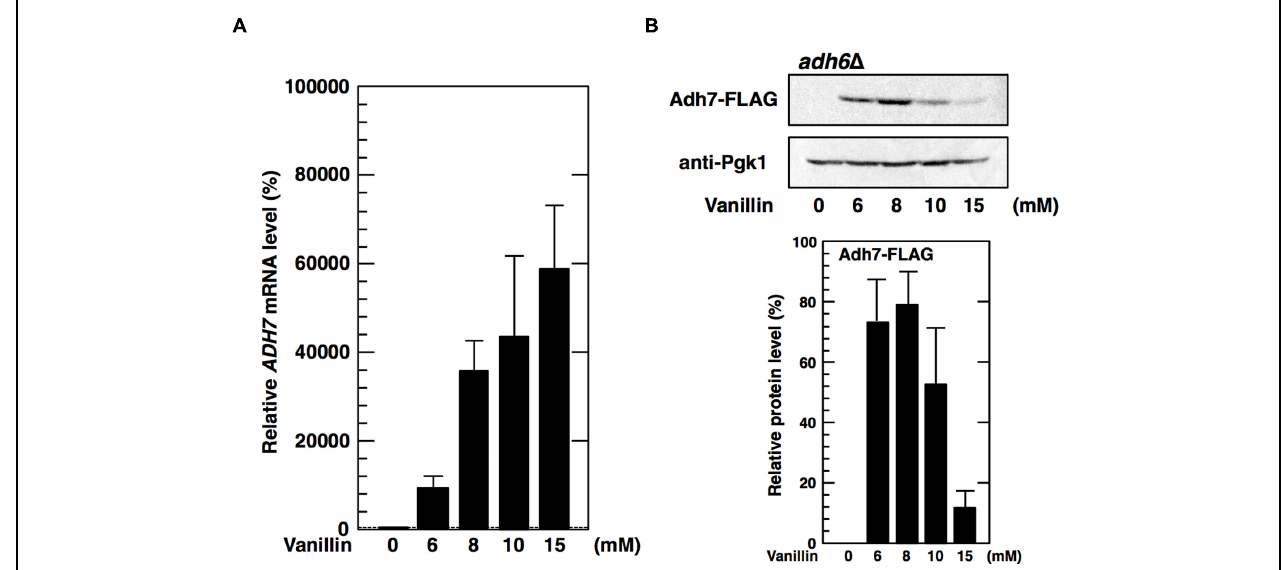
FIGURE 3 | Deletion of the ADH6 gene has no significant effect on the expression of the ADH7 gene. The adh6 (cid:2) cells carrying a FLAG-tagged chromosomal copy of the ADH7 gene were treated with vanillin for 60 min. (A) The mRNA levels of ADH7 were analyzed using qRT-PCR. To compare mRNA expression levels, the mRNA level of each gene was normalized to that of ACT1 . The mRNA level in cells without vanillin treatment was considered 100%. Data are shown as the mean ± SD of three independent experiments. (B) Adh7 levels were determined by western blot analysis using an anti-FLAG antibody. Pgk1 was used as a loading control. Protein levels of Adh7 were normalized to that of Pgk1 using ImageJ, the intensity of Pgk1 band of each lane was considered 100%. Data are shown as the mean ± SD of three independent experiments.